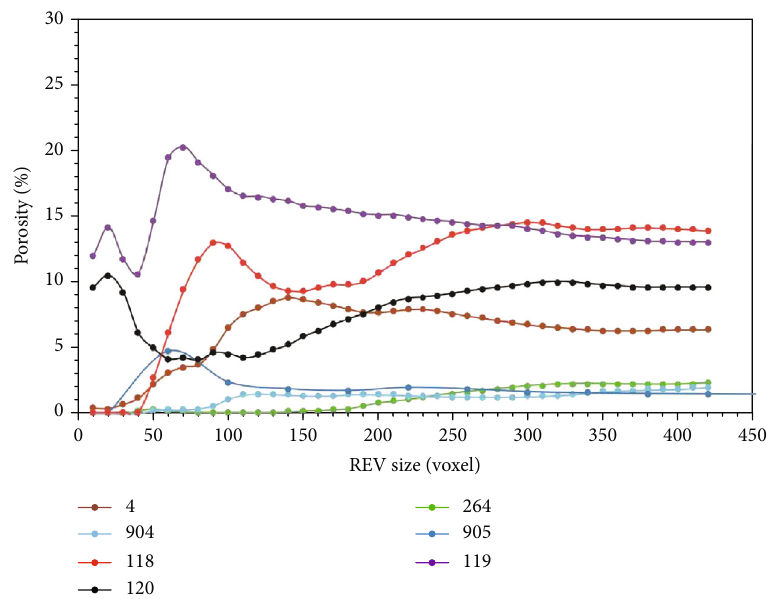
Figure 10: REV calculation with the coordinate from the bottom of the 3D